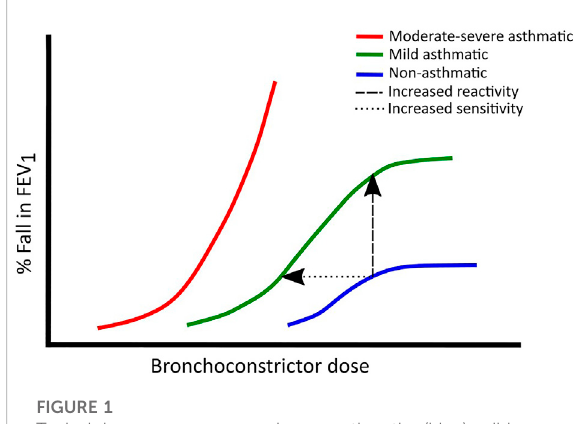
FIGURE 1 Typical dose-response curves in non-asthmatics (blue), mild asthmatics (green) and moderate to severe asthmatics (red). Leftward shifts show increased sensitivity whereas upward shifts show increased reactivity. Adapted from (Woolcock et al.,